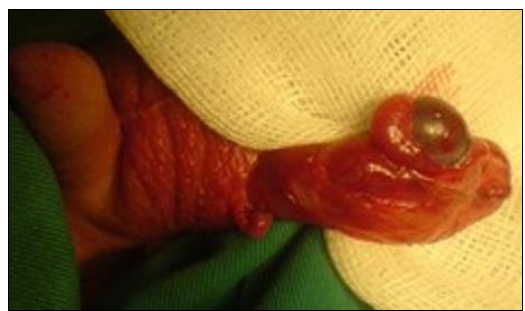
Figure 5: Showing evisceration of the testis from the scrotal